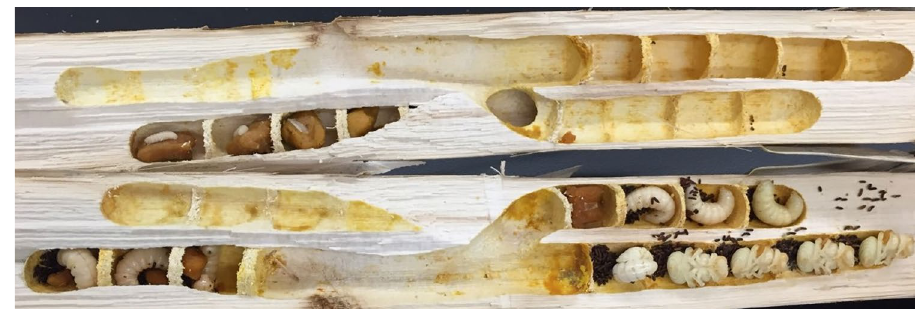
Figure 1. Dried Sotol stalks where carpenter bees were collected. Note the presence of larvae and